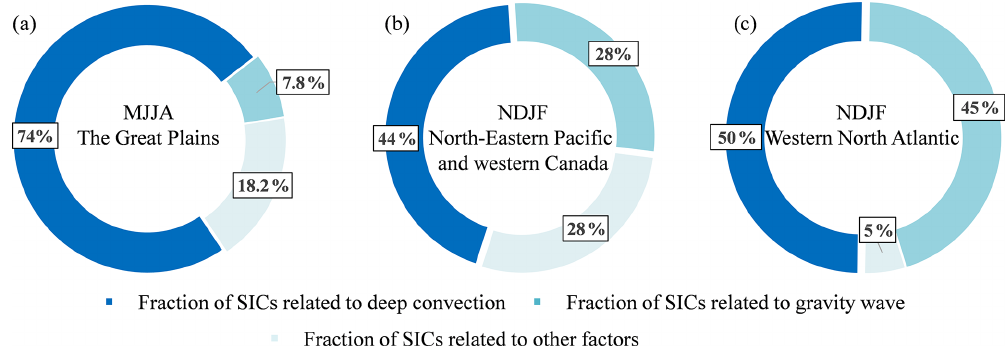
Figure 12. Maximum contribution fraction of deep convection, gravity waves, and other factors related to the occurrence of SICs over the Great Plains in MJJA (a) , over the north-eastern Pacific and western Canada in NDJF (b) , and over the western North Atlantic in NDJF (c) . Note that the maximum occurrence frequencies of SICs are about 6% over the Great Plains in MJJA, 4.4% over the north-eastern Pacific and western Canada, and 5.5% over the western North Atlantic in